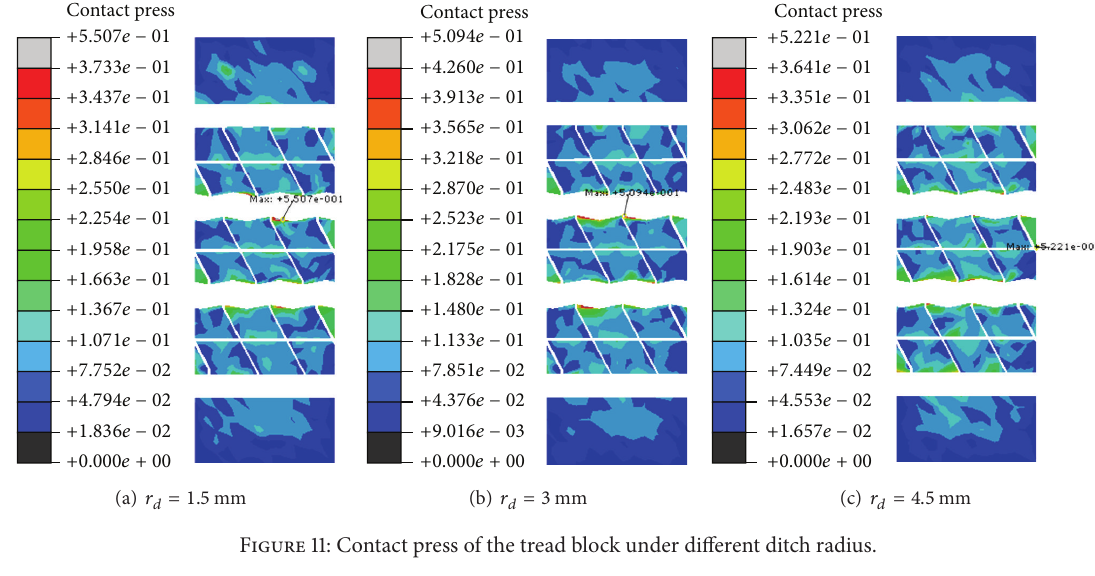
Figure 11: Contact press of the tread block under different ditch radius.